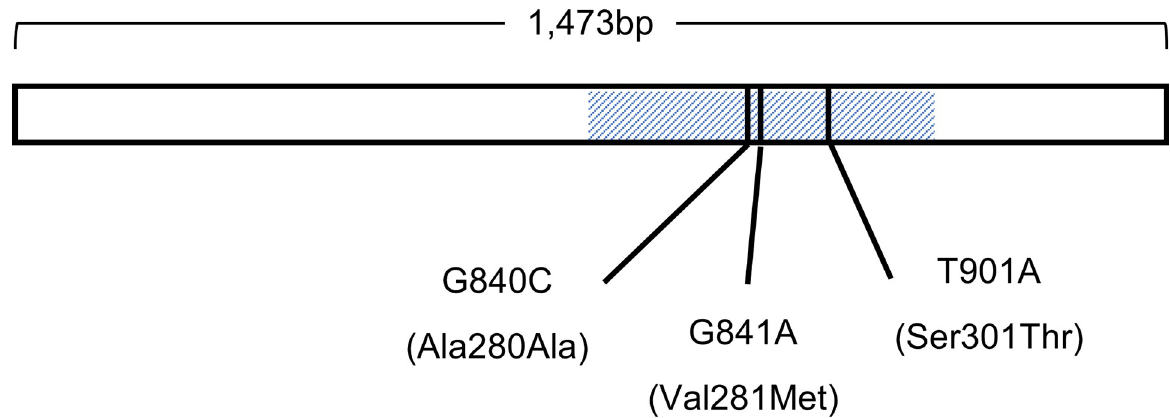
Fig 2. Locations of the single nucleotide polymorphisms on the single exon of the common marmoset serotonin receptor 1a gene. The shaded region corresponds to the third intracellular region.